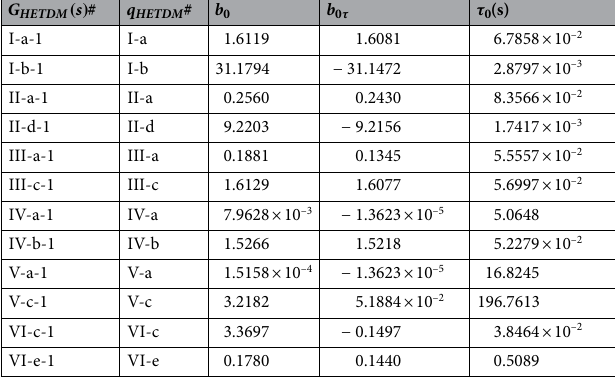
Table 7. HETDM transfer function numerator parameters computed via the LM method.